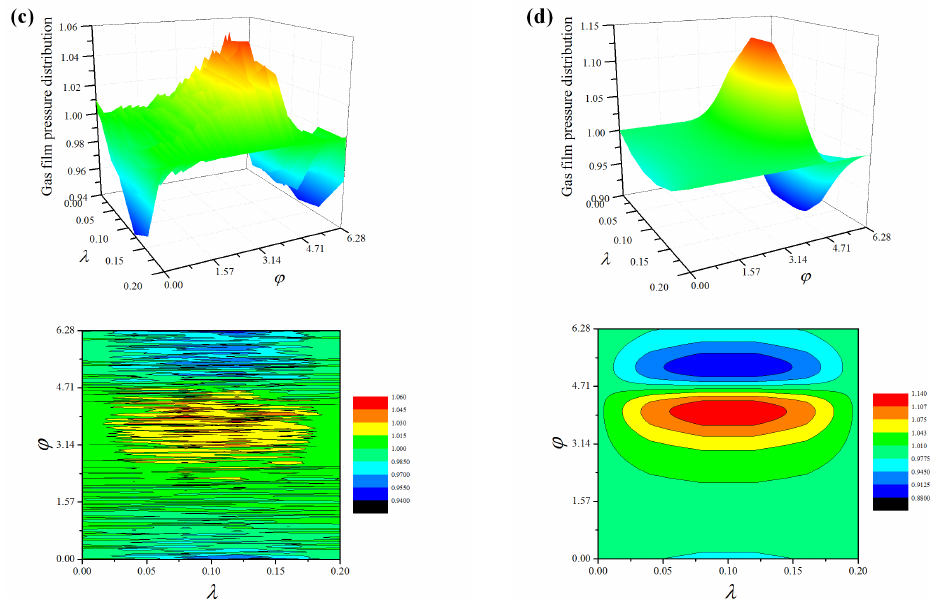
Figure 5. Pressure distributions and contour plots of the gas-lubricated microbearing for different bearing numbers and eccentricity ratios: ( a ) ε = 0.6, Λ = 20, D f = 2.3, and G = 1 × 10 −10 m, ( b ) ε = 0.6, Λ = 60, D f = 2.3, and G = 1 × 10 −10 m, ( c ) ε = 0.3, Λ = 20, D f = 2.3, and G = 1 × 10 −10 m, and ( d ) ε = 0.6, Λ = 20, smooth.